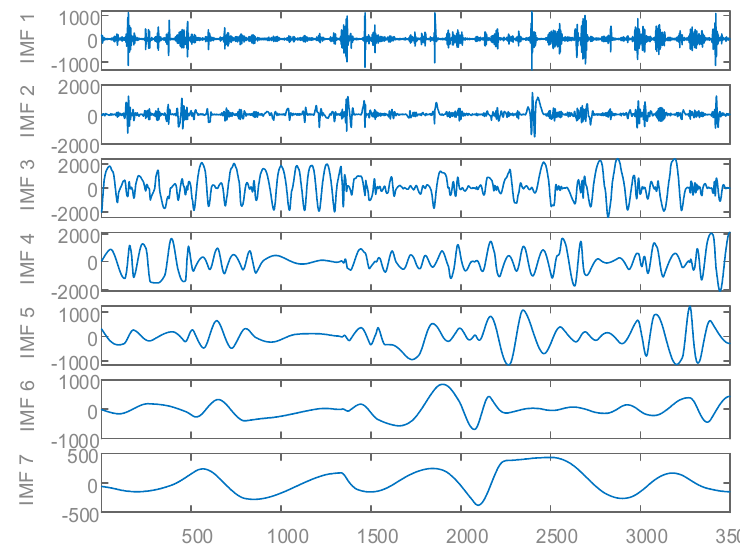
Figure 5. PV historical power time series.